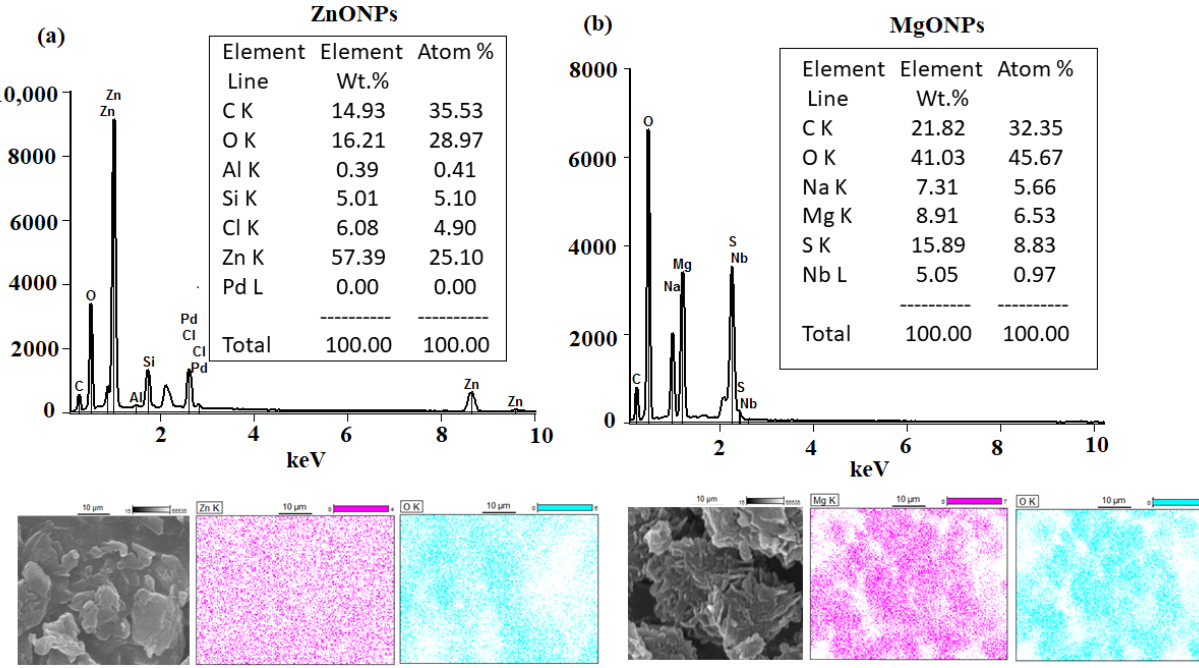
Figure 7. The EDX spectra and mapping analysis of the ( a ) ZnONPs and ( b ) MgONPs.